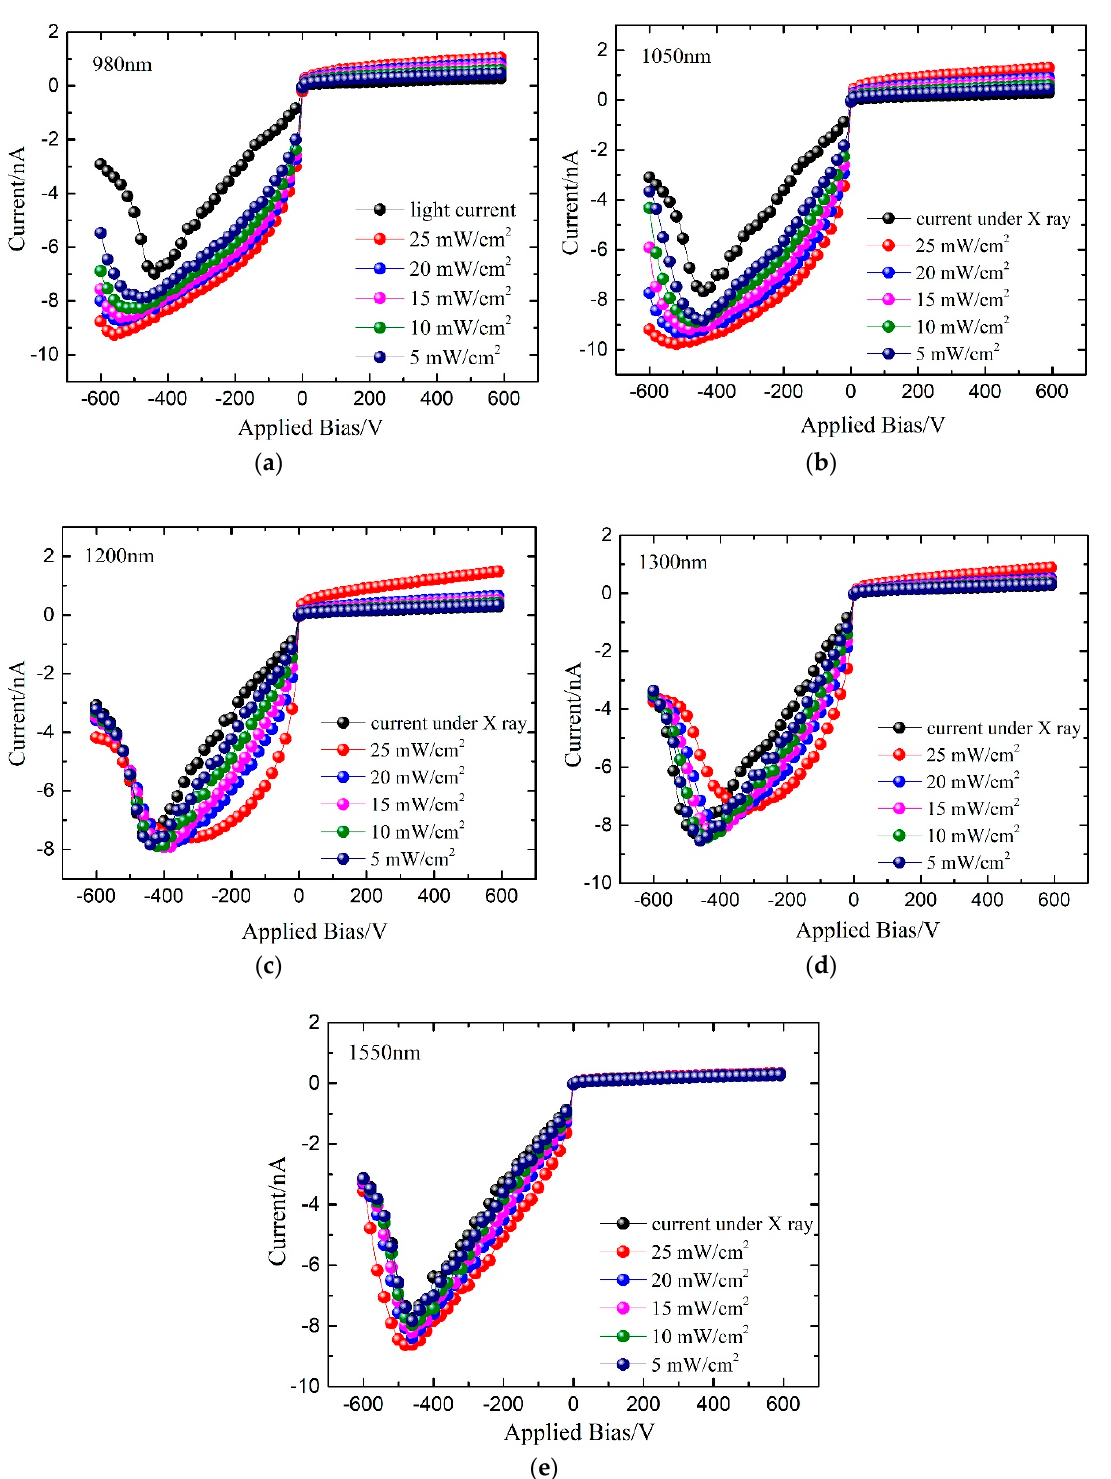
Figure 3. Photo I–V curves of CdZnTe detectors under the radiation of infrared light in the wavelengths of 980 nm ( a ), 1050 nm ( b ), 1200 nm ( c ), 1300 nm ( d ), and 1550 nm ( e ) with X-ray irradiation.